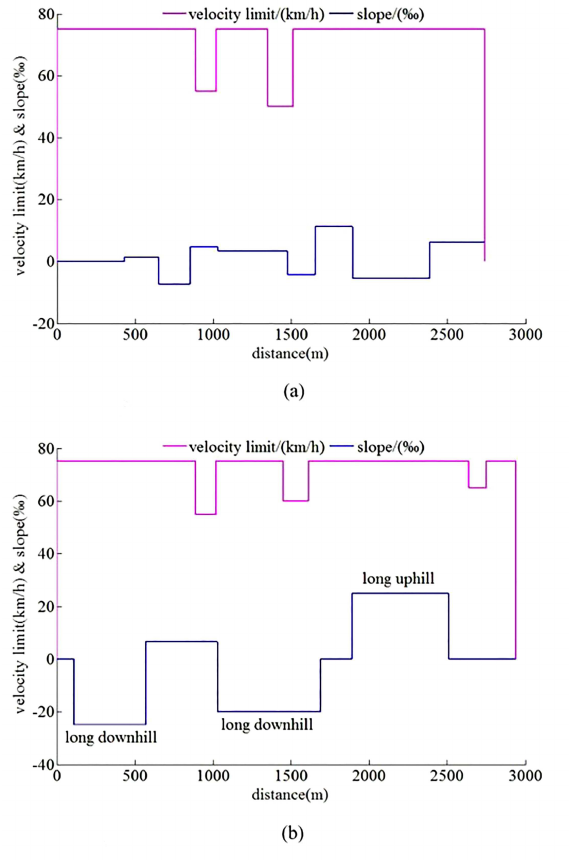
Figure 5. The ramp parameters and the speed limit of experiment simulation for two ATO scenarios. ( a ) Jinpu line No.1 in Dalian scenario. ( b ) rail transit line No.12 in Dalian